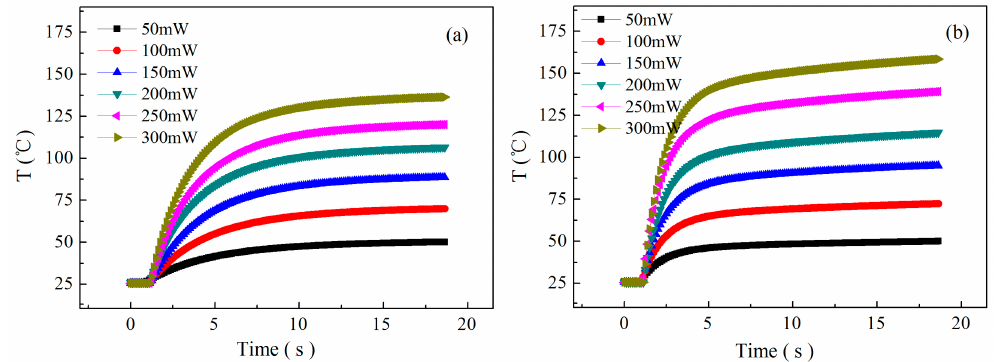
Figure 7. The thermal response characteristic curves of the sensor at different power consumptions ( a ) before thermal isolation and ( b ) after thermal isolation.